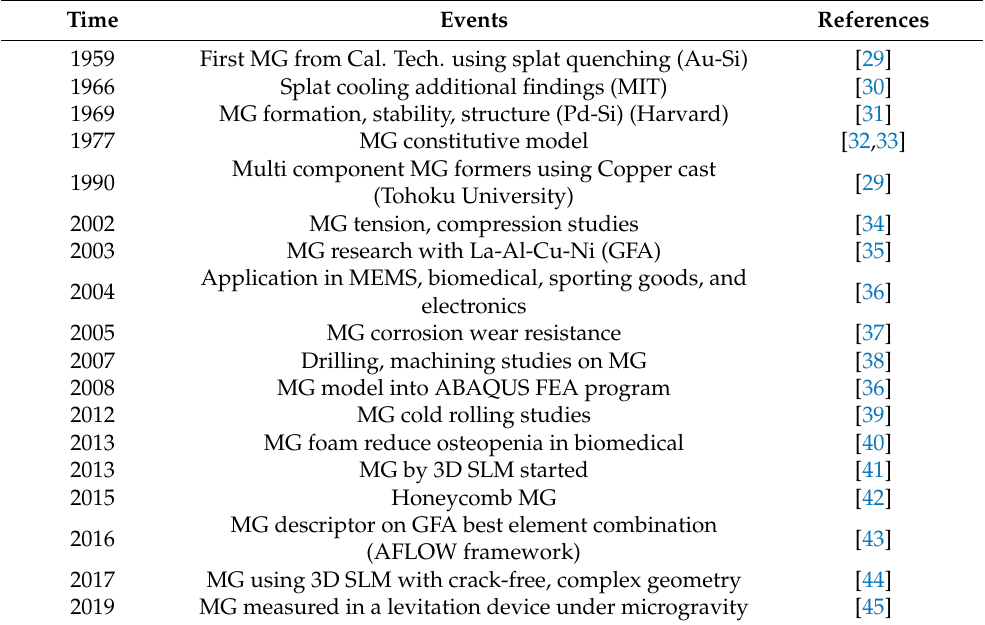
Table 1. Summary of Amorphous Research